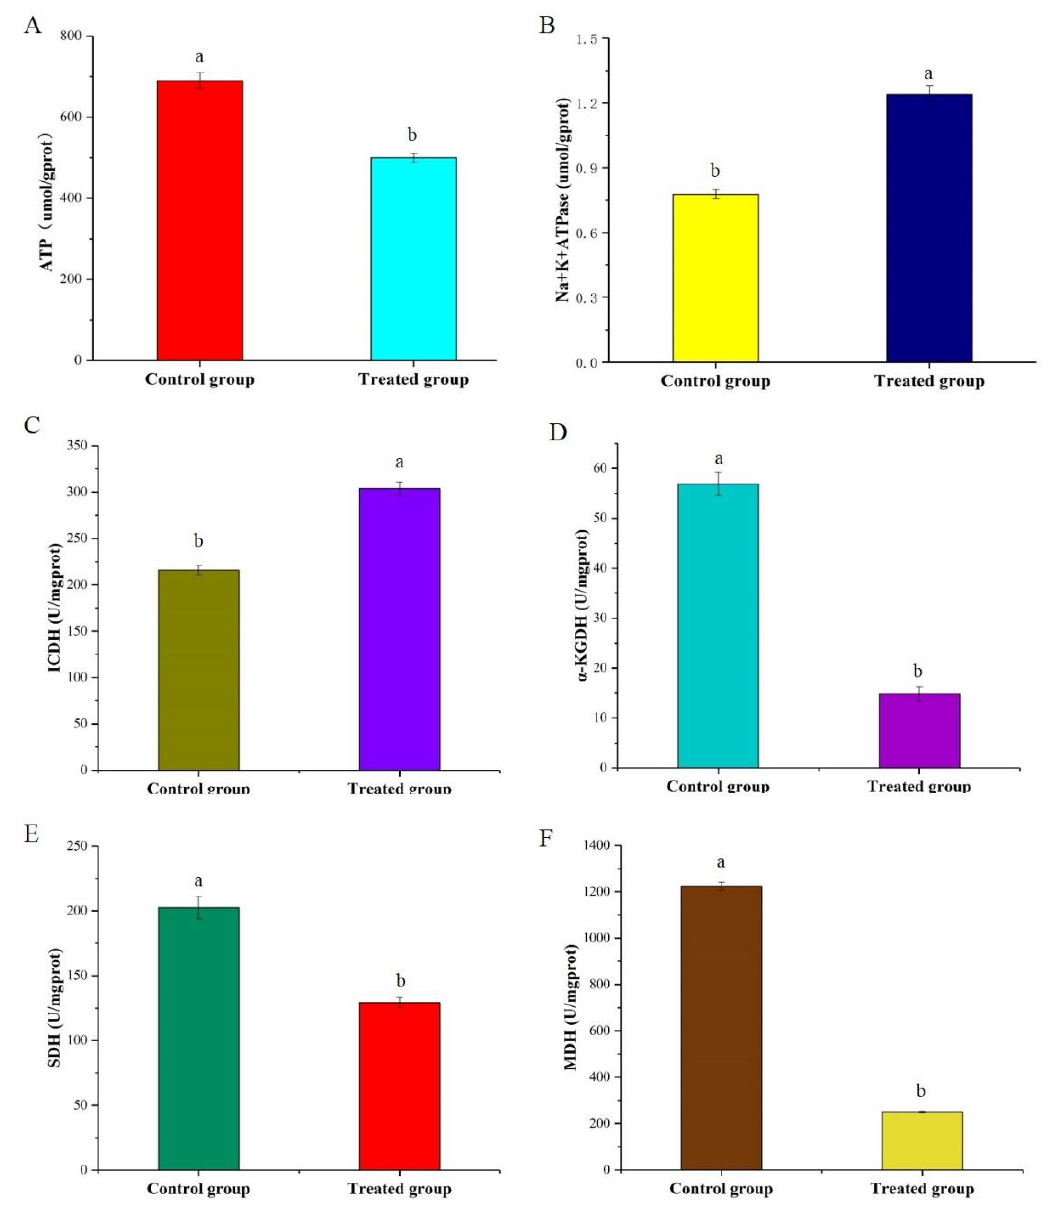
Figure 4. Effects of the skin mucus extract on intracellular ATP ( A ), Na + /K + ATPase activity ( B ), ICDH activity ( C ), α -KGDH activity ( D ), SDH activity ( E ), and MDH activity ( F ) of S. aureus . Letters (a and b) indicated the significance between each group.